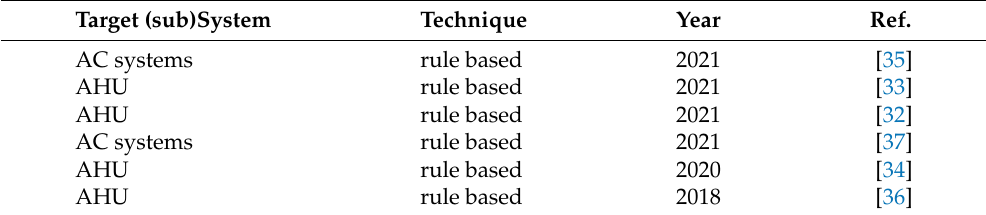
Table 2. Brief summary of related work addressing the knowledge discovery approach in HVAC FDD. For clarity, all acronyms are provided in the Abbreviations list.